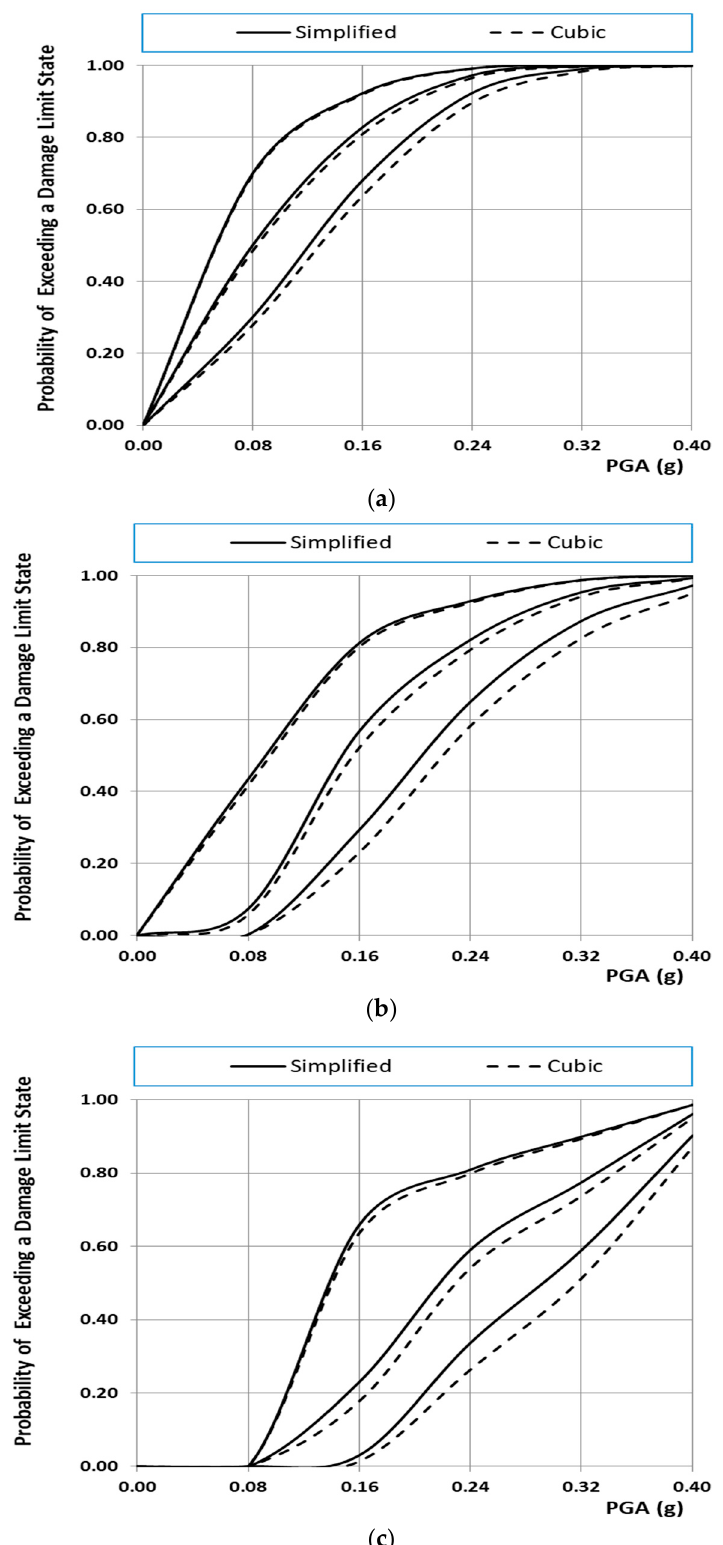
Figure 13. Fragility curves of the structure before and after interventions using the cubic tensor polynomial failure criterion: ( a ) insignificant damage; ( b ) moderate damage; ( c ) heavy damage.